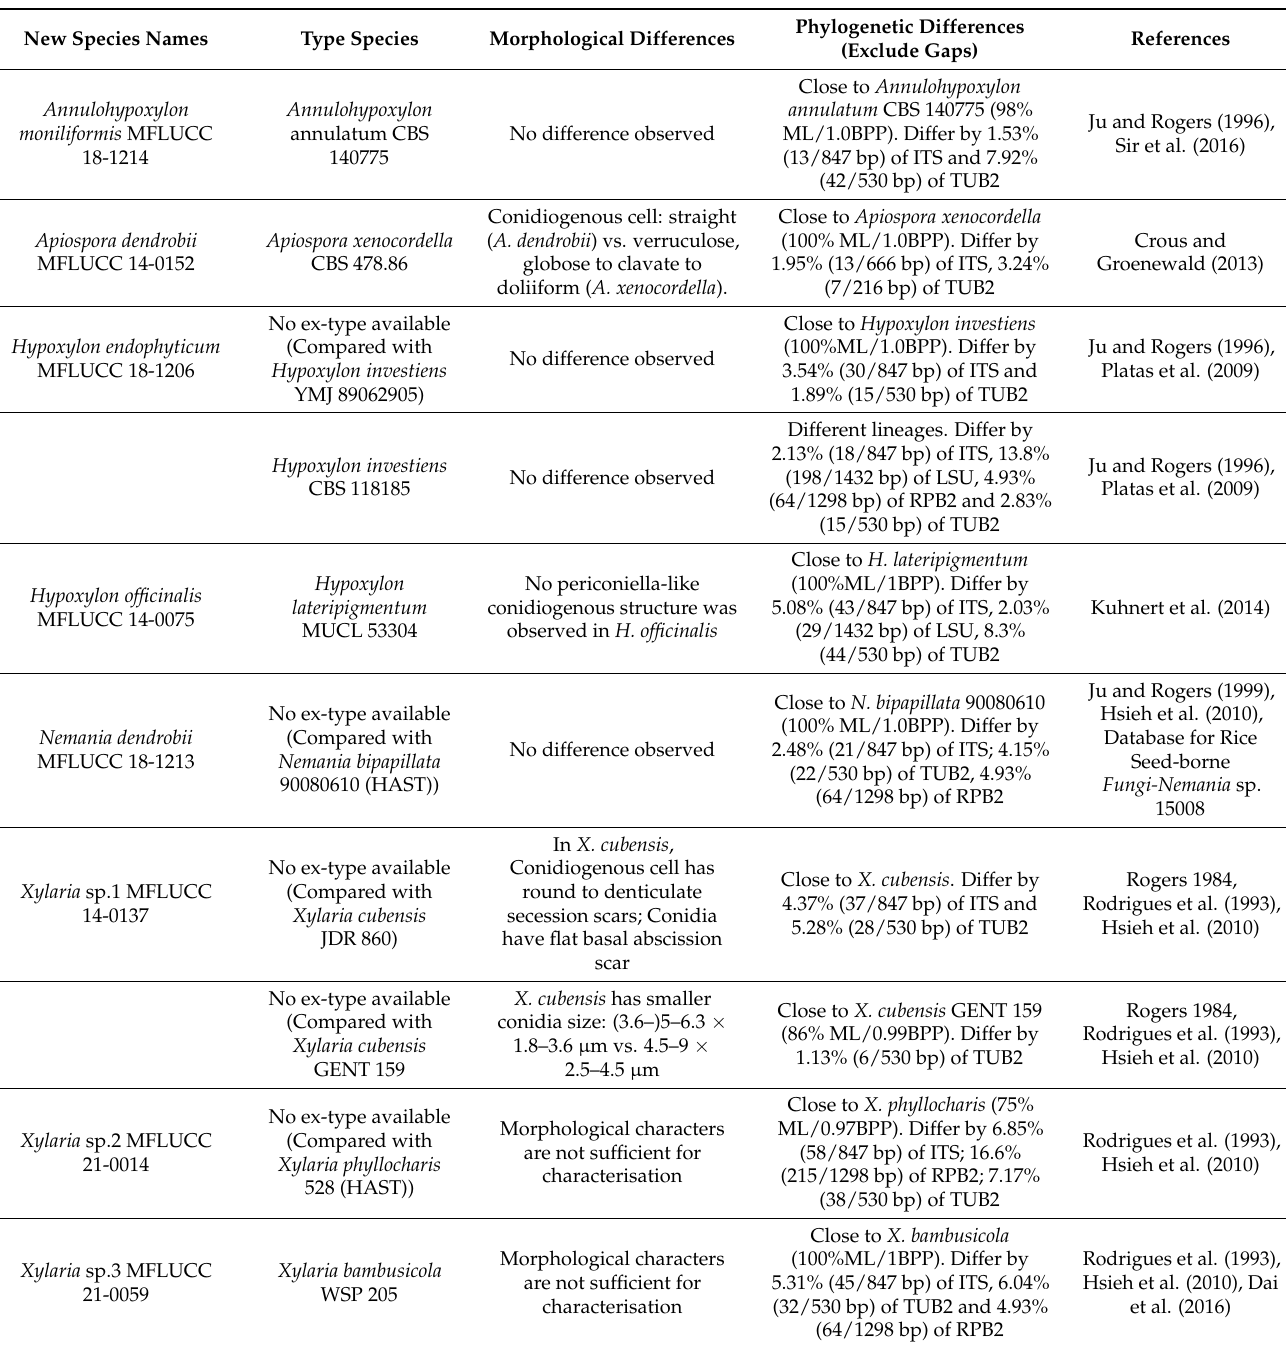
Table 4. Comparison of the (tentative) novel species with the closest related